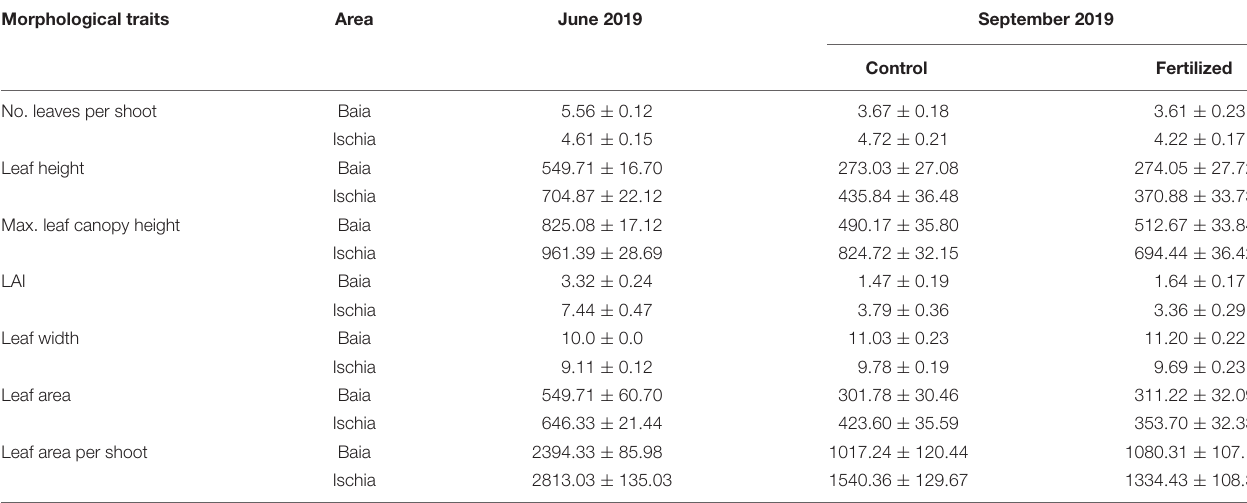
TABLE 1 | Mean ( ± SE) values of morphological traits from P. oceanica meadows ( n = 12) from the anthropogenically impacted sites (Baia- Gulf of Pozzuoli) and low impacted sites (Ischia) in control ( n = 6) and fertilized ( n = 6) plots. Morphological traits